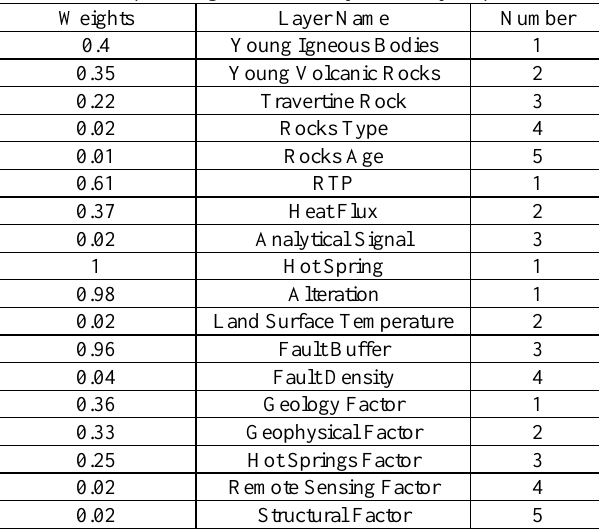
Table 1. Expert weights obtained by the Fuzzy/Ahp